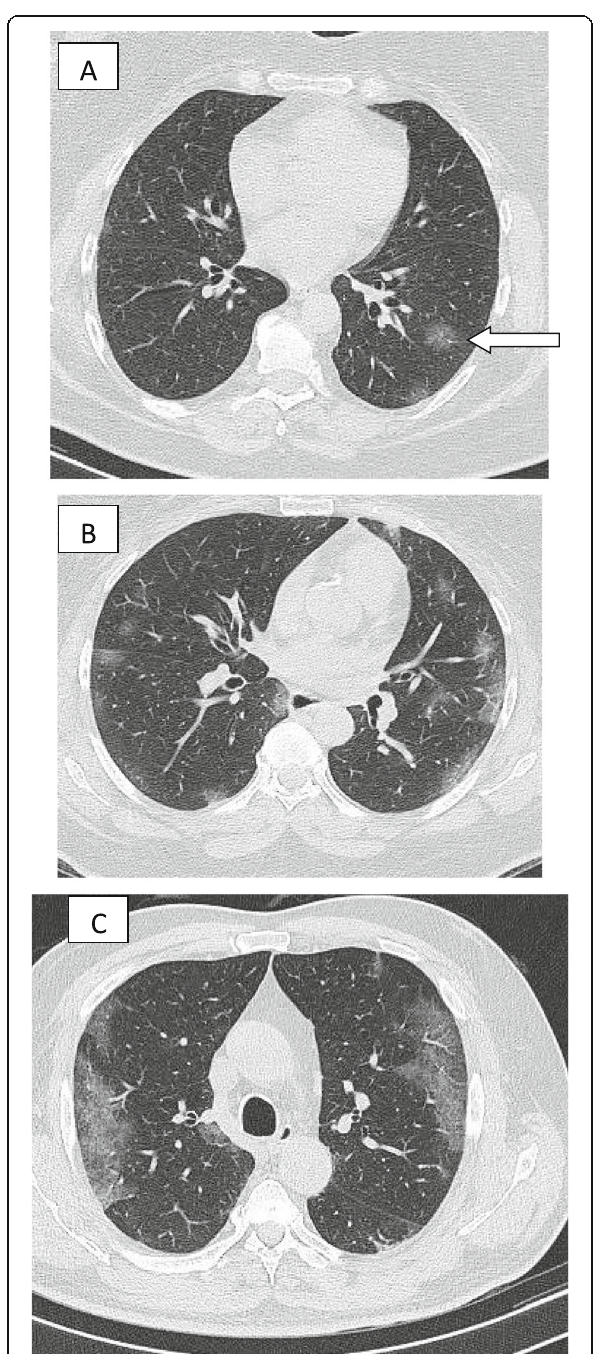
Fig. 1 Three different cases of early COVID-19 pneumonitis. a Patient in second day after appearance of symptoms with ill-defined early ground glass infiltration patches in the left lower lobe. b Patient in third day of symptoms with multiple patchy areas of sub- pleural ground glass infiltration in both lungs. c Another patient 4 days after symptoms with bilateral wide areas of ground glass infiltration